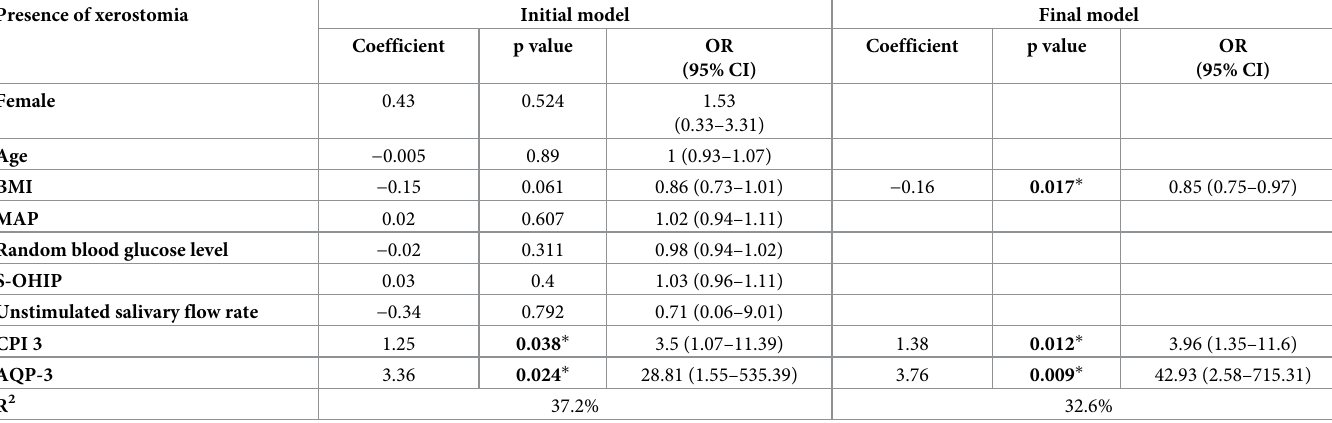
Table 5. Binary logistic regression analysis of presence of xerostomia in patients with periodontal disease. Presence of xerostomia